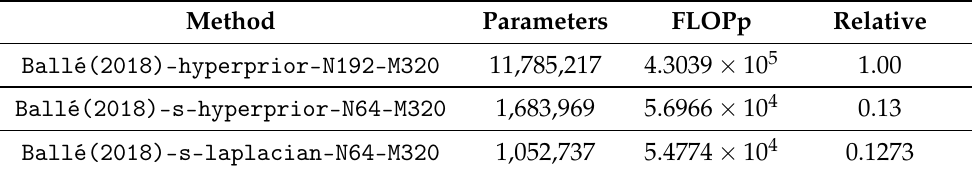
Table 3. Comparative complexity of the global architectures-Case of target rates above 2 bits/pixel.